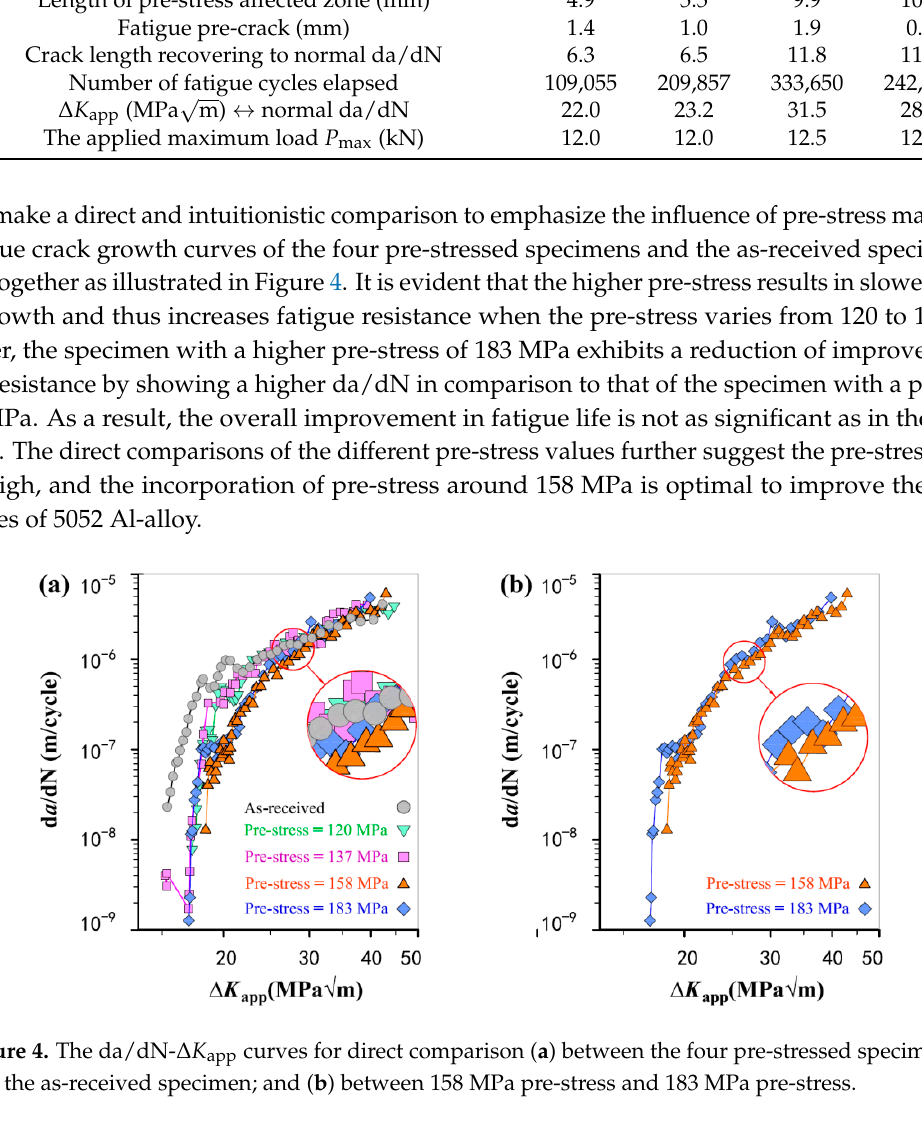
Figure 4. The da/dN- Δ K app curves for direct comparison ( a ) between the four pre-stressed specimens and the as-received specimen; and ( b ) between 158 MPa pre-stress and 183 MPa pre-stress.